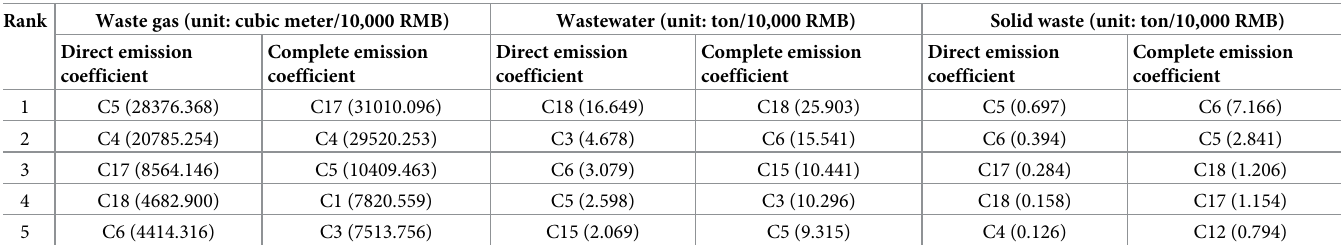
Table 2. Top 5 industries with the highest emission coefficient. Rank Waste gas (unit: cubic meter/10,000